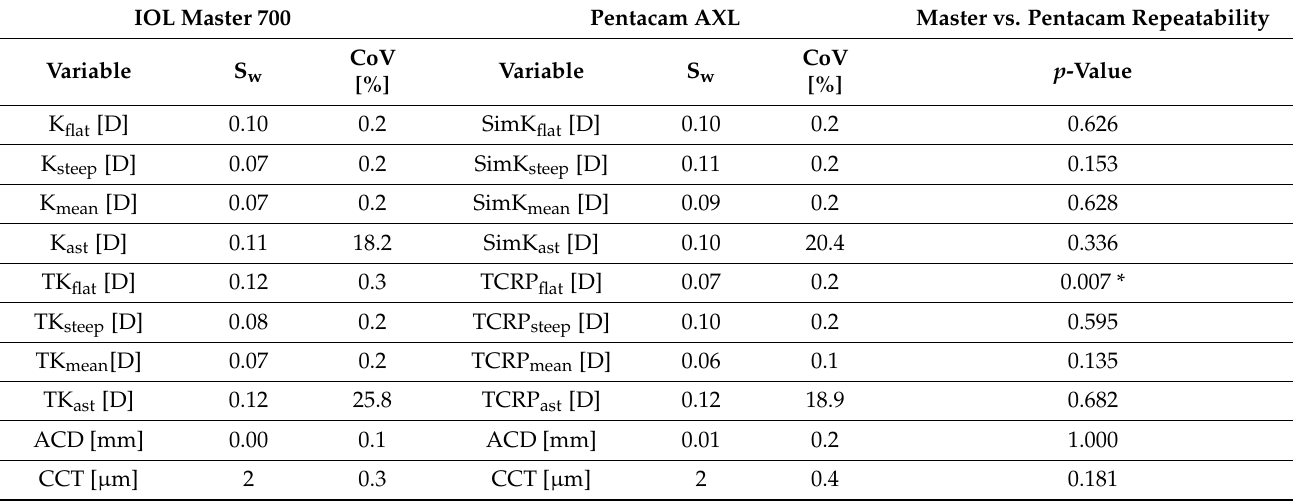
Table 2. Comparison of the repeatability of the measured